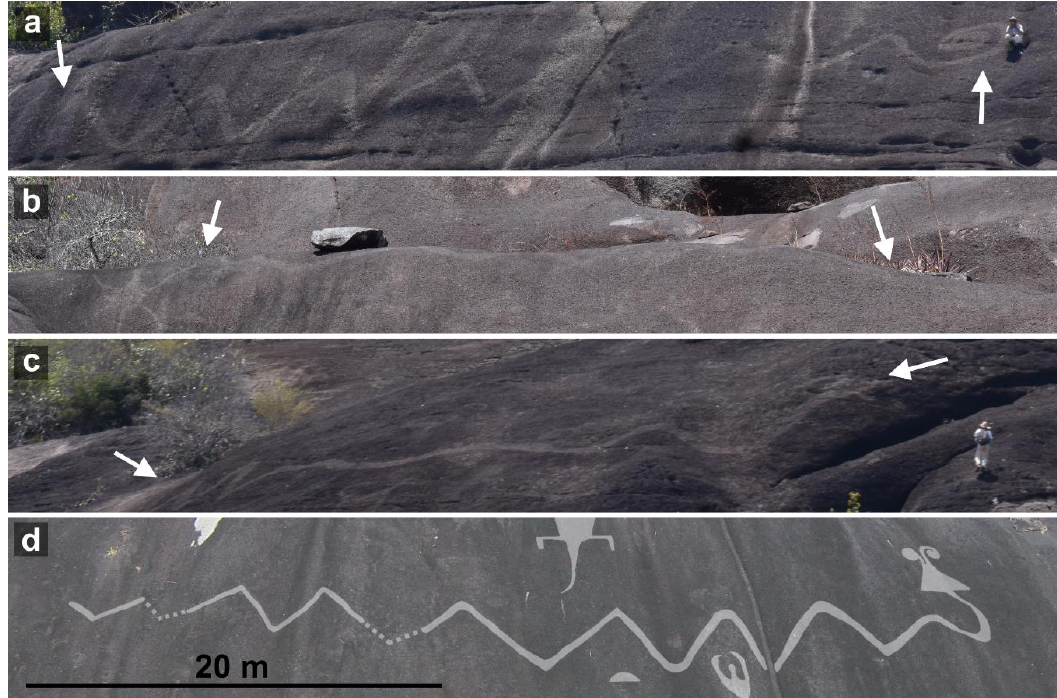
Figure 6. Large snake motifs recorded in the Middle Orinoco, with humans for scale. Arrows indicate extent in absence of enhanced image overlay. ( a ) Cerro Palomazón, ( b ) Cerro Dagua, ( c ) Cerro Casuarito, ( d ) Cerro Pintado.